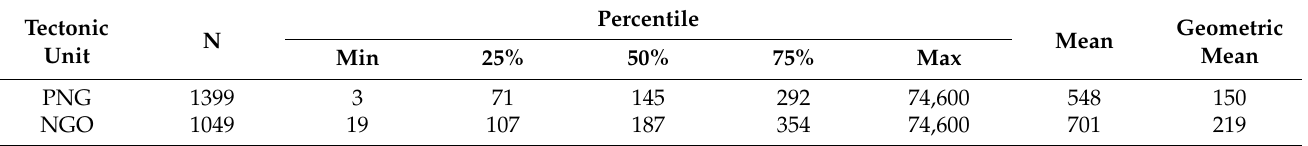
Table 4. The statistical parameters of the chromium concentration (ppm) of stream sediments in different tectonic units based on the national-scale geochemical mapping project data. NGO: New Guinea